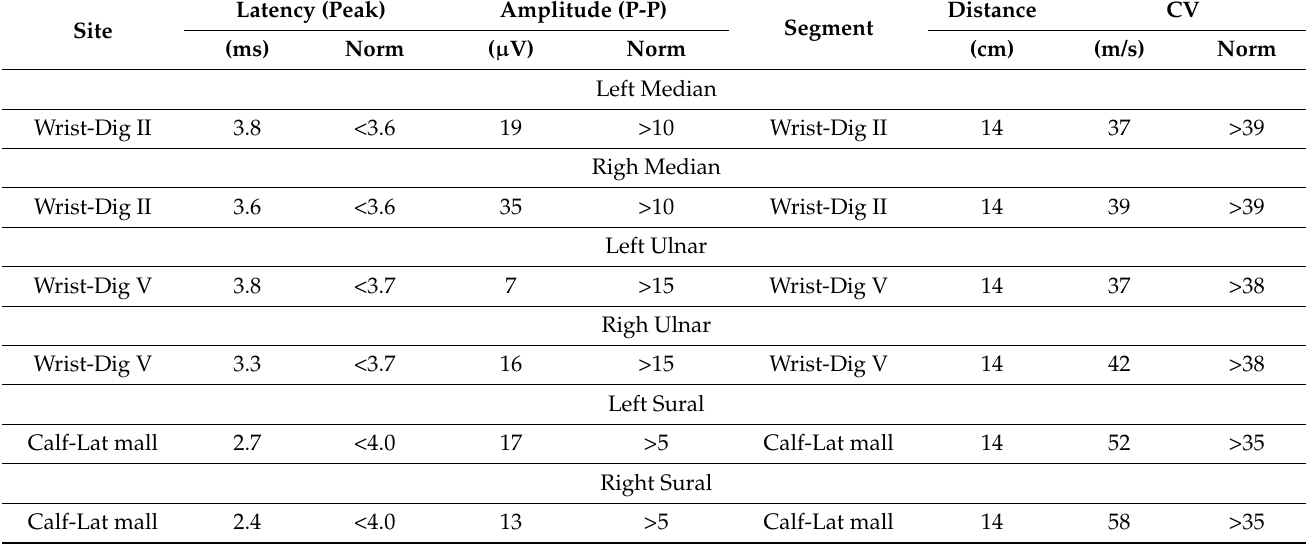
Table 3. The study of peripheral, sensory nerve conduction velocities shows a moderate to severe sensory polyneuropathic process, with a mixed pattern but axonal predominance that affects the four extremities with greater expression in the lower extremities and predominance on the